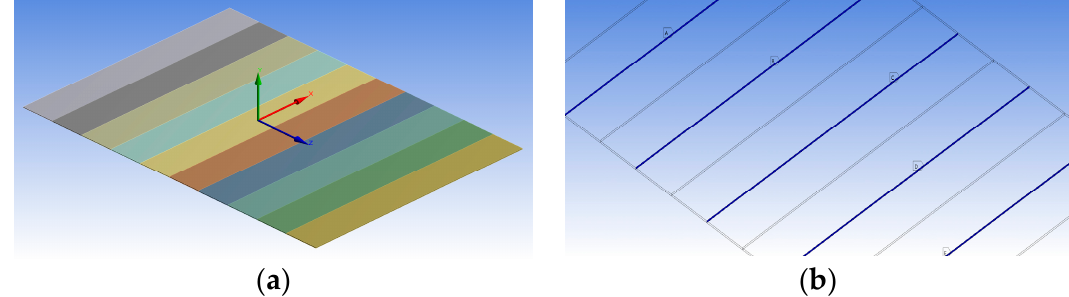
Figure 3. ( a ) FEM of multiple segments of piezoelectric actuators of MFC with the coordinate system. ( b ) Blue surfaces indicate positive voltage and gray surfaces indicate zero voltage in the finite element model.